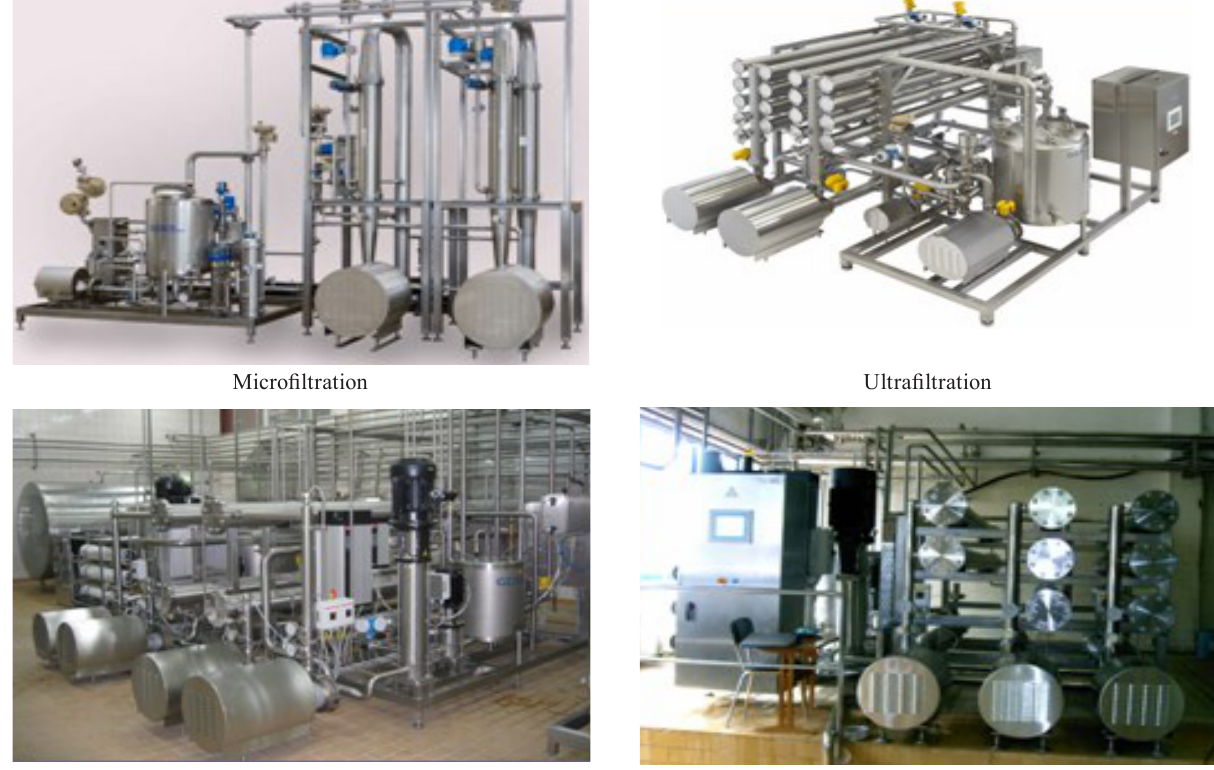
Figure 2 Baromembrane installations for molecular sieve filtration of